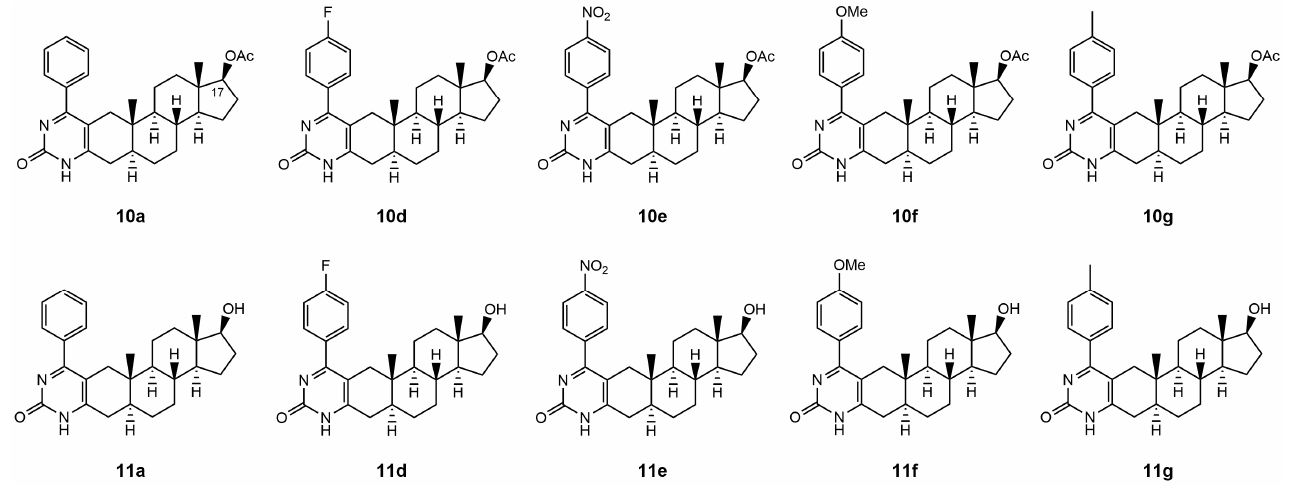
Figure 1. Chemical structures of androstane-derived A-ring-fused arylpyrimidines 10a , 10d , 10e , 10f , 10g , 11a , 11d , 11e , 11f, and 11g differing in their C-17 functionality.